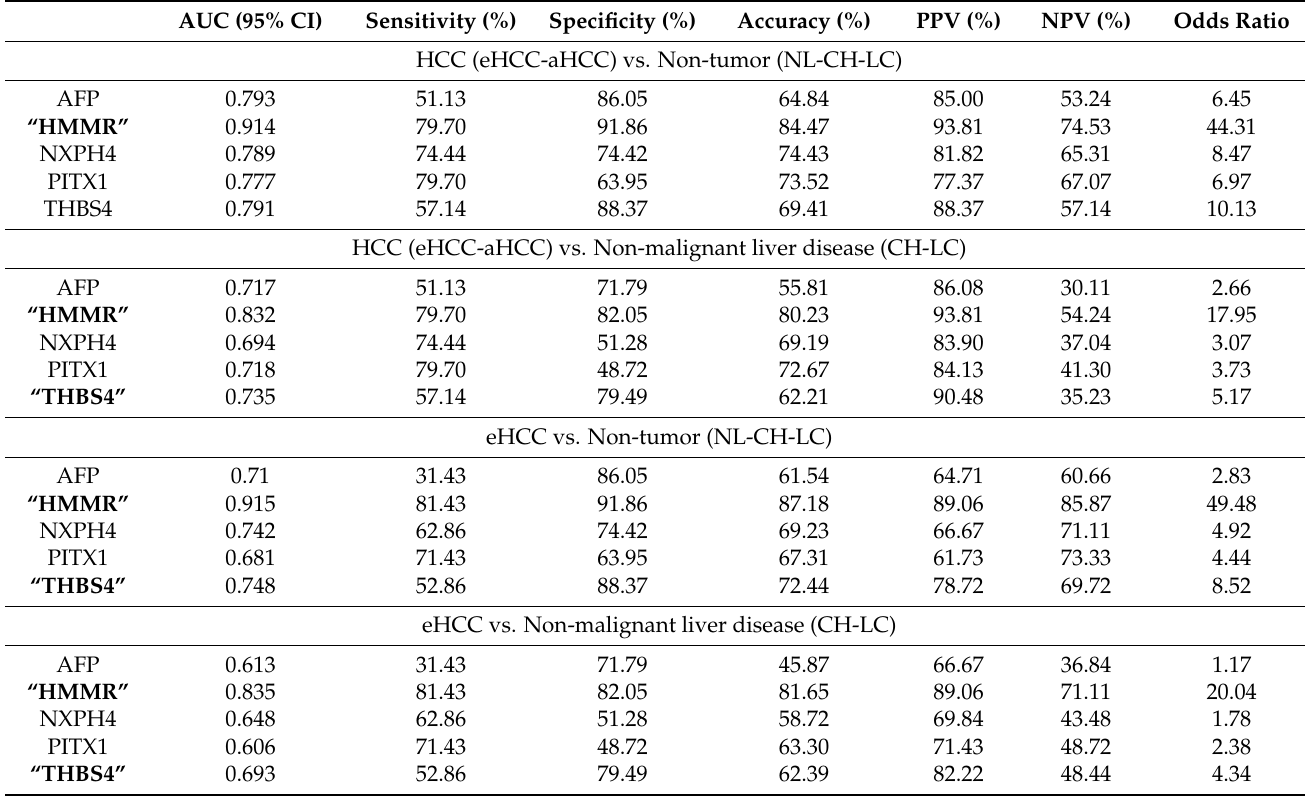
Table 1. Results for measurement of HMMR, NXPH4, PITX1 and THBS4 serum markers and AFP in the diagnosis of